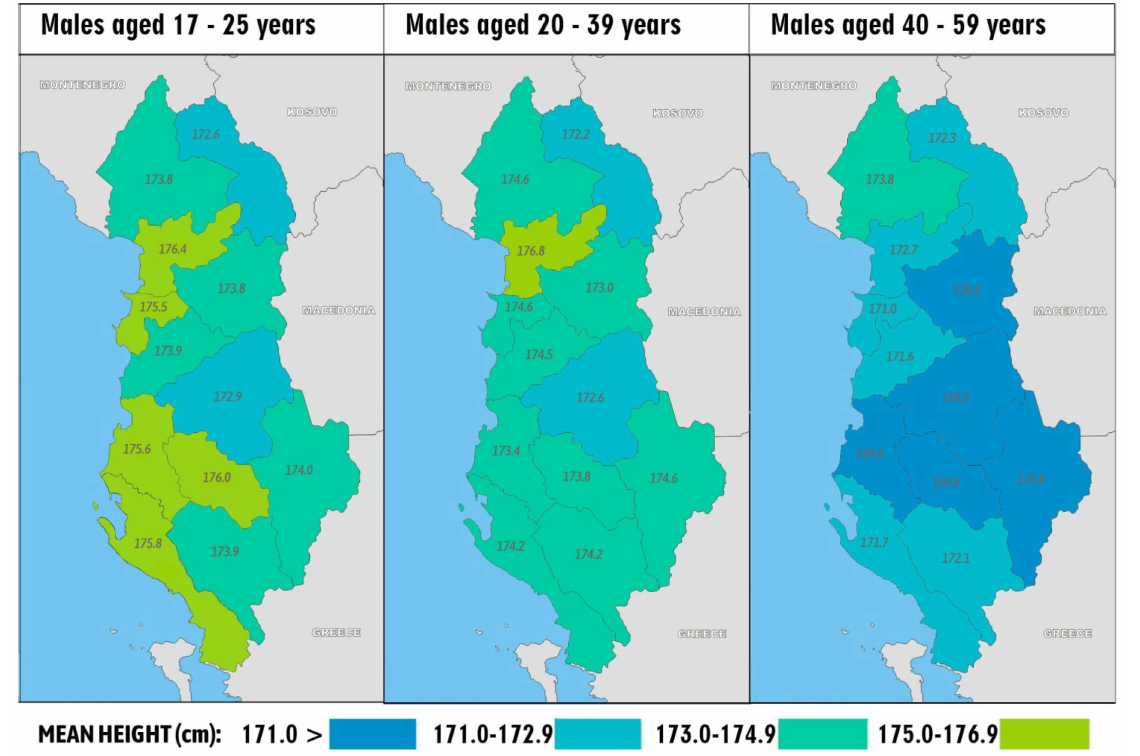
Figure 6. Regional differences in male height within Albania, according to different age categories: 17–25 years ( n = 1273), 20–39 years ( n = 2502), and 40–59 years ( n = 2072). Source: